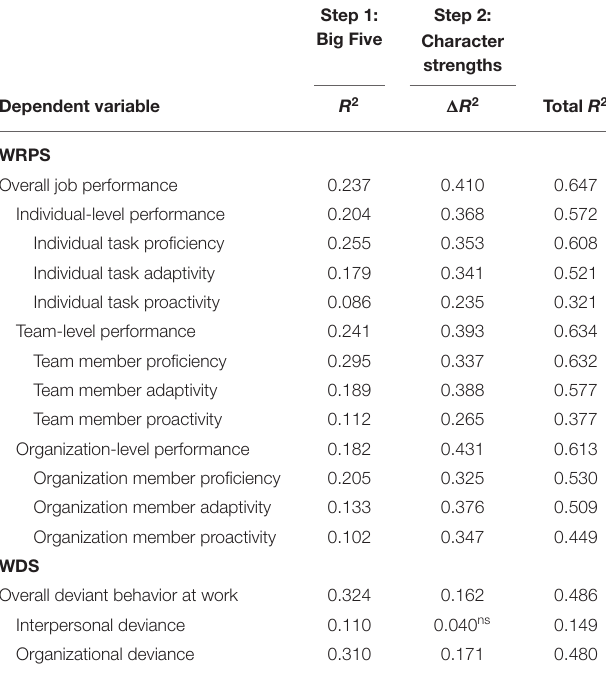
TABLE 6 | Hierarchical linear regression analyses: explained variance (Olkin–Pratt adjusted) in dependent variables by the Big Five (Step 1; method: Enter; MRS-25 scales) and character strengths (Step 2; method: Enter; VIA-IS120 scales with partial correlation coefficients ≥ 0.25 in accordance with Table 4